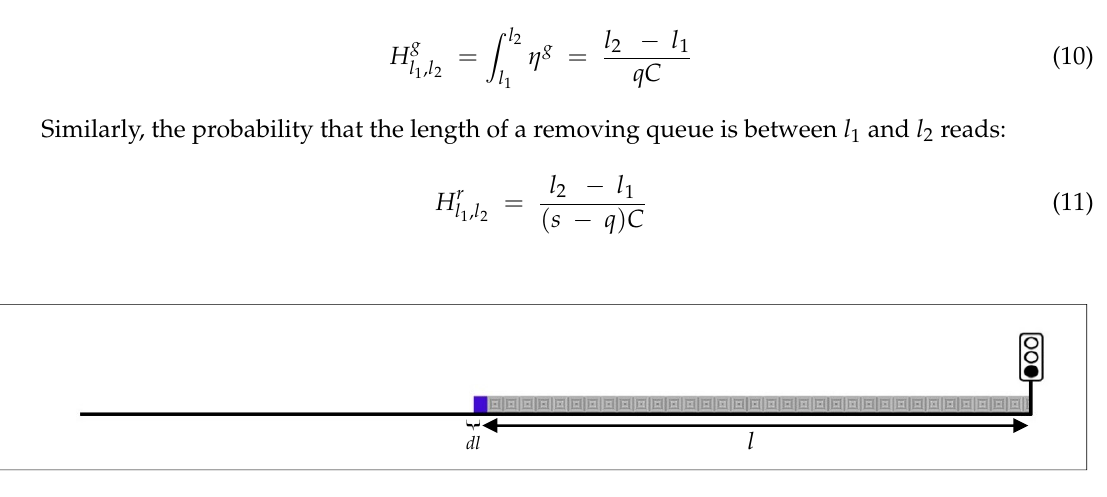
Figure 3. The differential part of a queue.